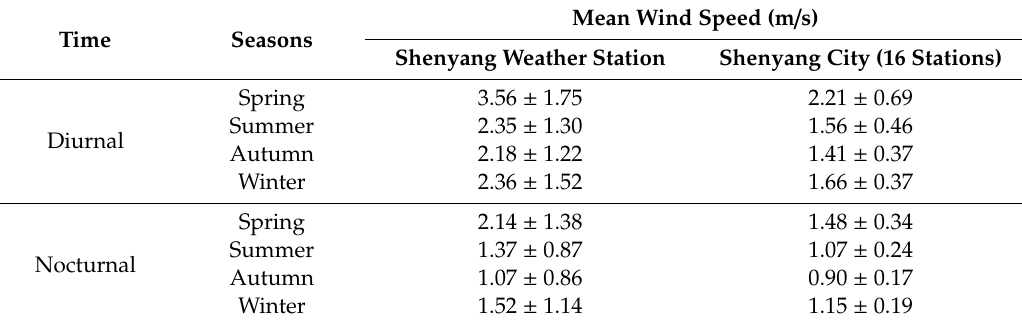
Table 4. Diurnal and nocturnal mean wind speed at Shenyang weather station and the 16 stations (2018).